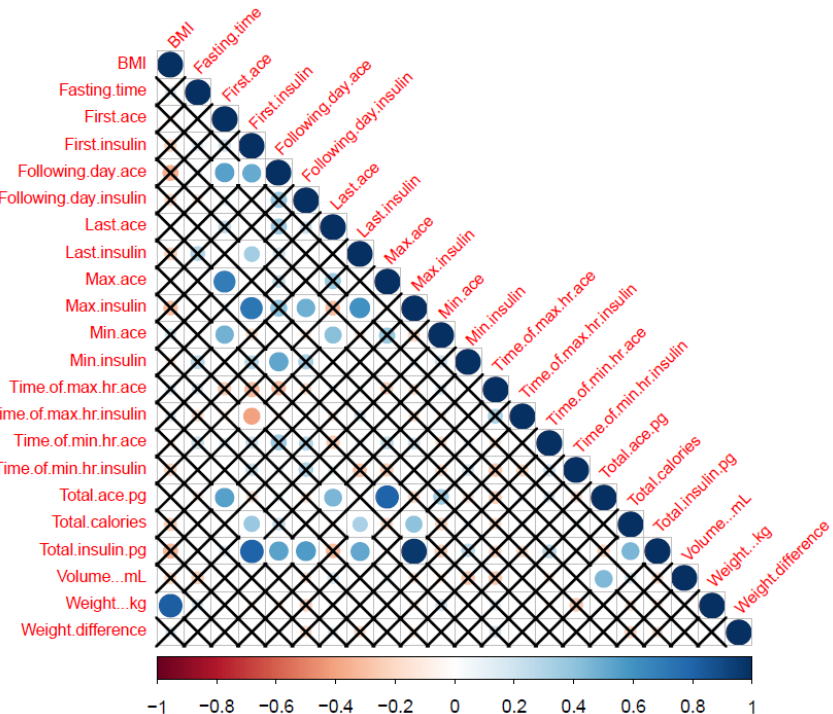
Figure 5. Correlation Matrix for ACE and Insulin. Correlations between the parameters were scaled from +1.0 to − 1.0. Blue indicates positive correlation while red indicates negative correlation. X indicates no correlation between the two parameters which is significant at p = 0.05.